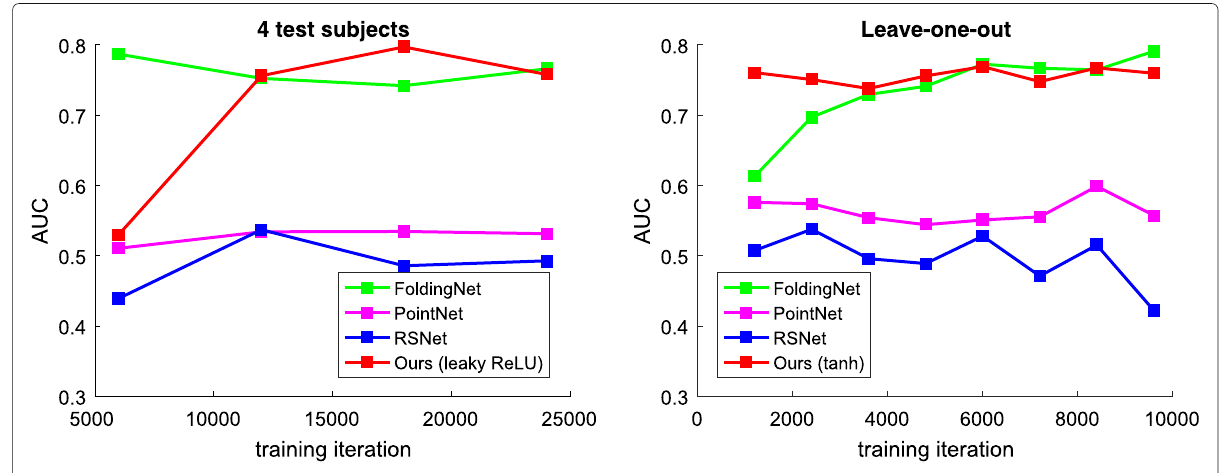
Fig. 9 AUCs estimated from our evaluation on deep learning models Chamfer distance in gait index calculation is not signif-